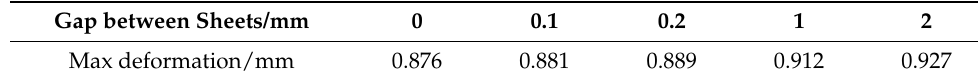
Figure 16. The deformation diagram of strap sheet with 0 gap. (Unit: mm).